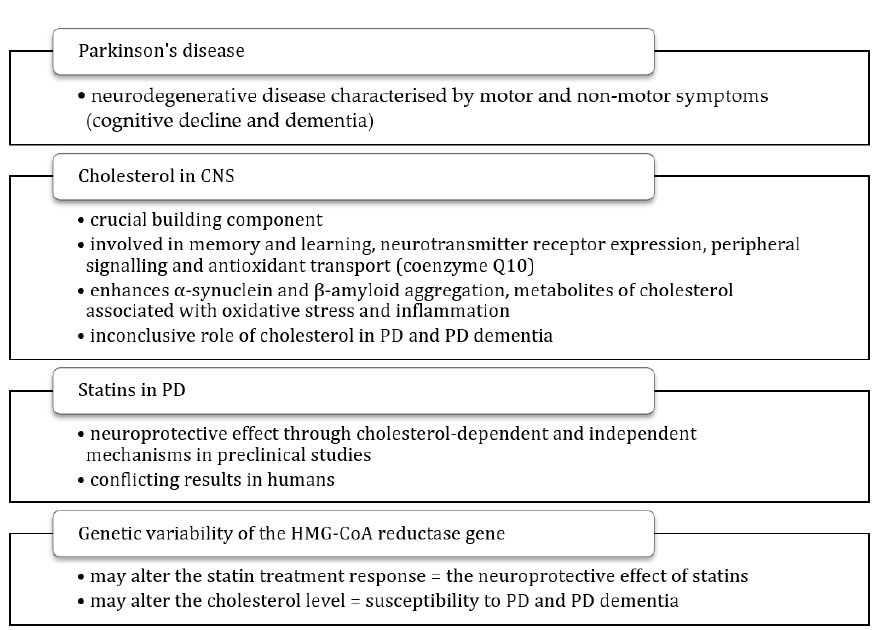
Figure 2. Summary of a potential role of cholesterol, statins, and genetic variability of the HMG-CoA reductase gene in Parkinson’s disease. CNS—central nervous system, PD—Parkinson’s disease.